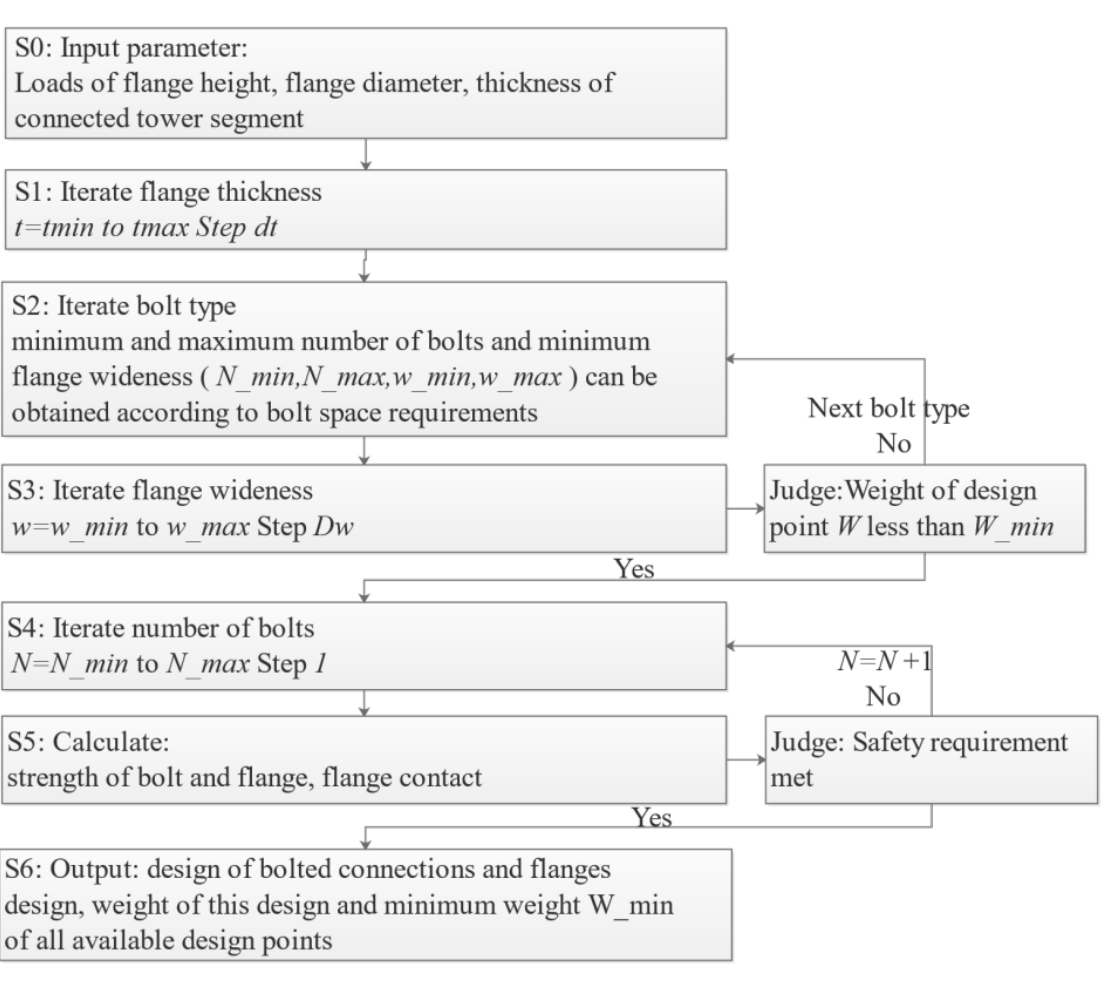
Figure 4. Bolted connections and flange design flow.